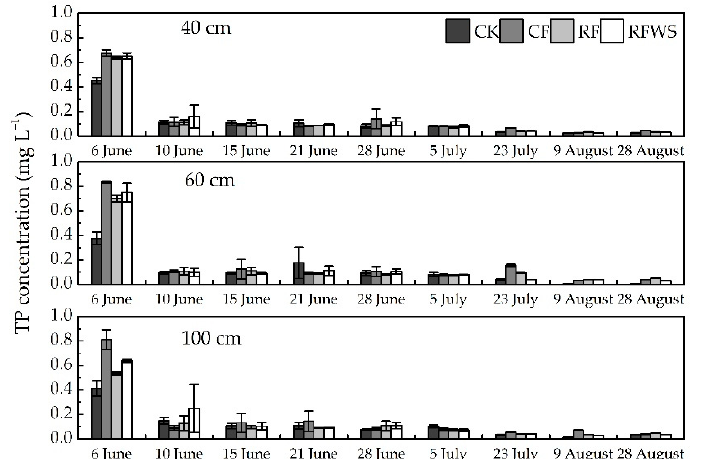
Figure 4. Changes in TP concentration in leaching water at different depths under different fertiliza- tion treatments.